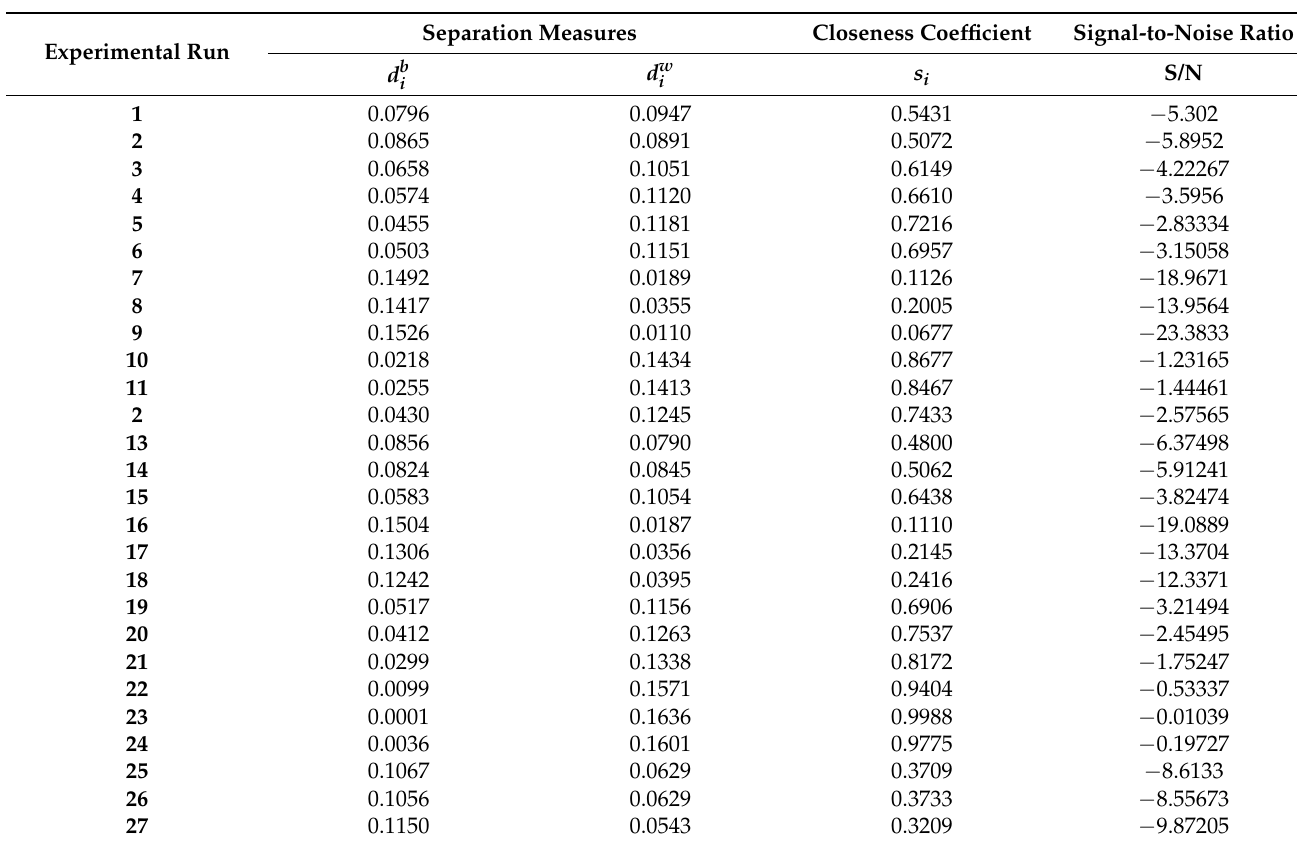
Table 6. Separation measures, closeness coefficient, and signal-to-noise ratios.